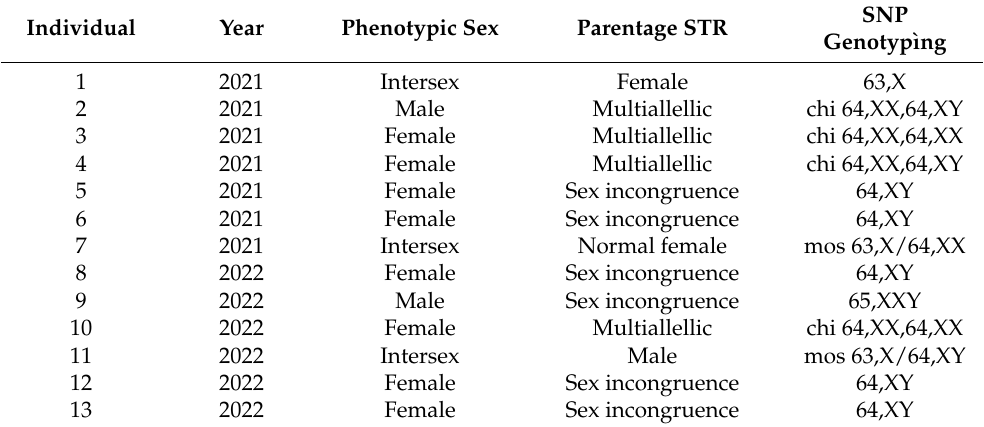
Table 1. Individuals carrying chromosomal abnormalities during the 24-month period in the PRE breed. Individual